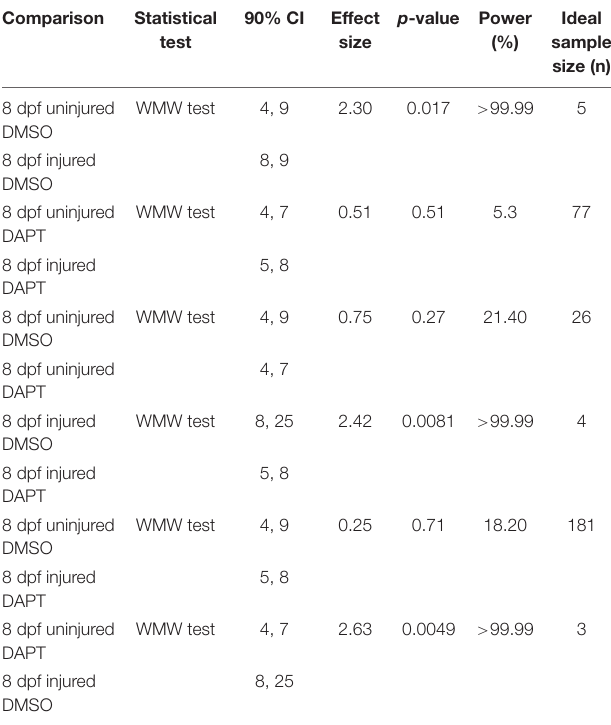
TABLE 4 | Calculation of statistical power for comparing the number of muSCs after muscle injury in 4 dpf zebrafish larvae in the presence of DAPT. Comparison Statistical test